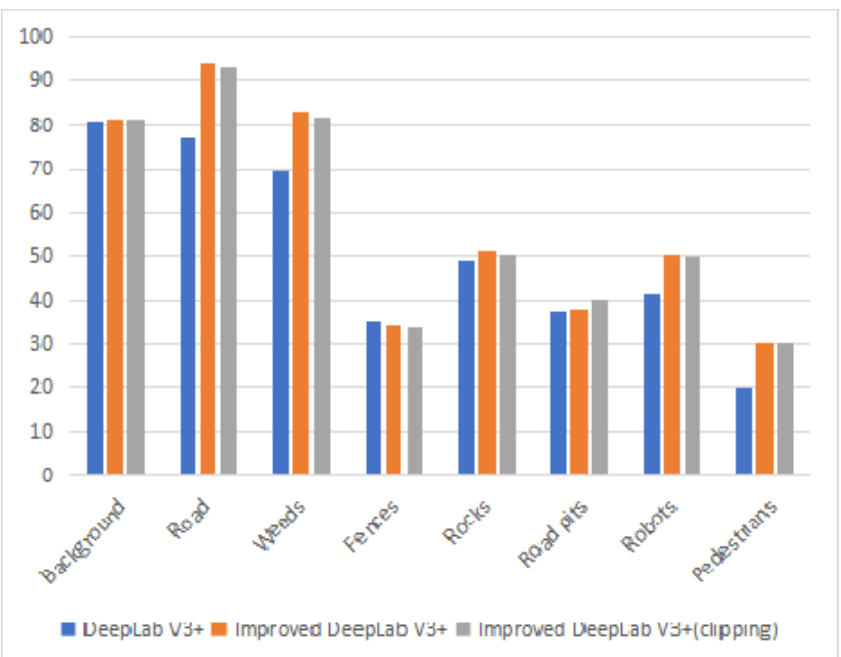
Figure 9. IoU test results for 8 types of targets in substations.